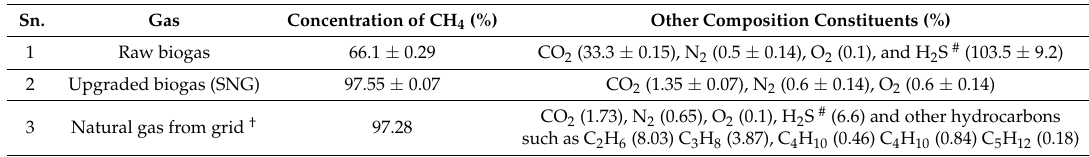
Table 1. Gas quality for different gas